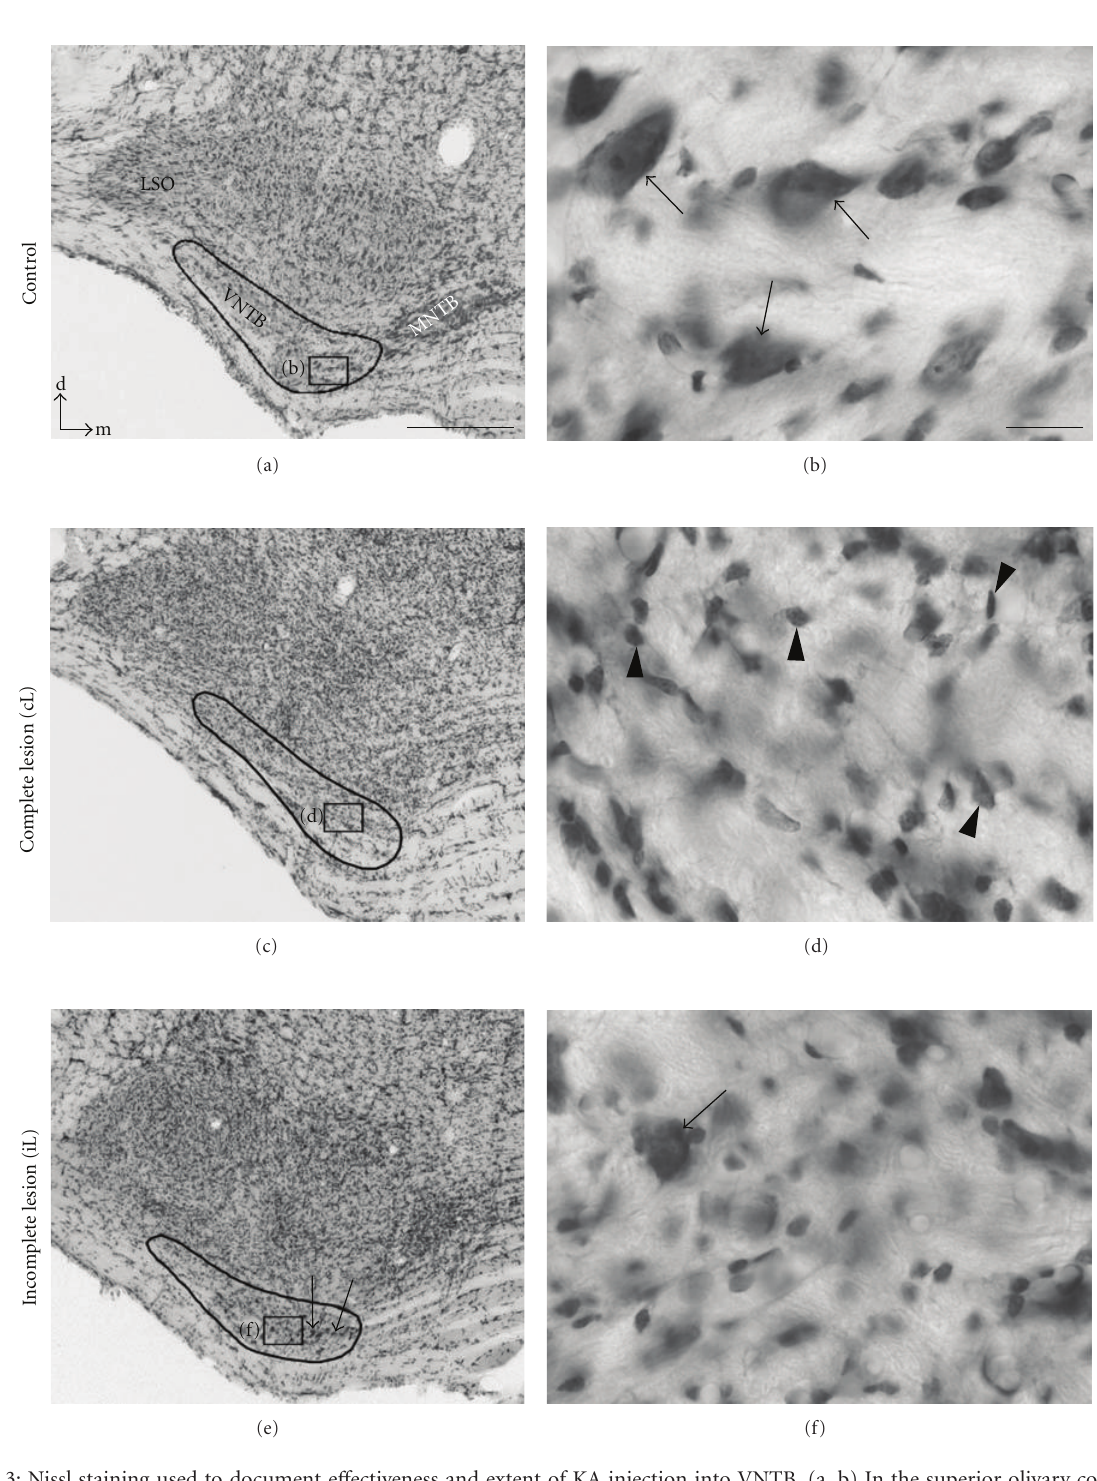
Figure 3: Nissl staining used to document e ff ectiveness and extent of KA injection into VNTB. (a, b) In the superior olivary complex of normal adult rats (a), numerous large neurons (arrows in (b)) were visible in VNTB (outlined in (a), (c), and (e)). Frames seen in (a), (c), and (e) indicate fields shown at high magnification in (b), (d), and (f). Dorsal (d) and medial (m) indicate orientation of brain sections. LSO: lateral superior olive; MNTB: medial nucleus of trapezoid body. (c), (d): VNTB with complete lesion (cL). All neurons have disappeared while glial cells (arrowheads in (d)) increased in number. (e, f) After incomplete VNTB lesions, neurons (arrows in (e) and (f)) survived in parts of VNTB (f). In the case shown in (e), medially residing neurons survived the injection (arrows) while most of the laterally residing neurons disappeared. Scale bar: 50 μ m for (a), (c), and (e); 20 μ m for (c), (d), and